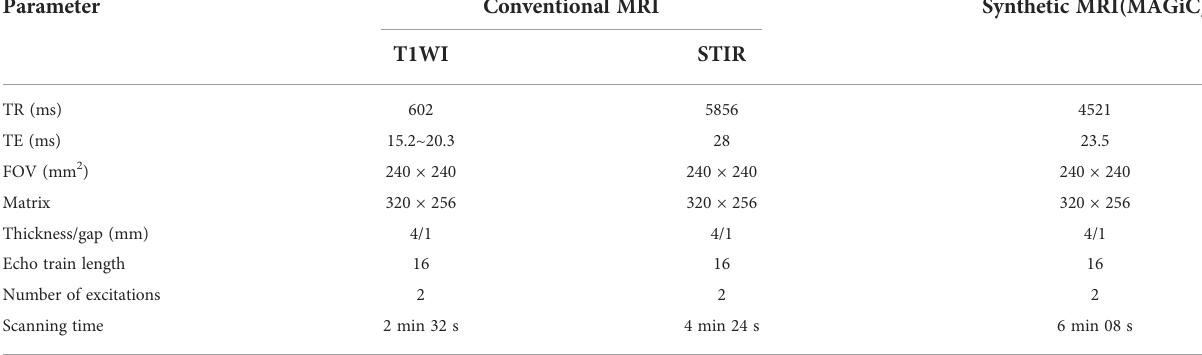
TABLE 1 Magnetic resonance imaging (MRI) protocol.